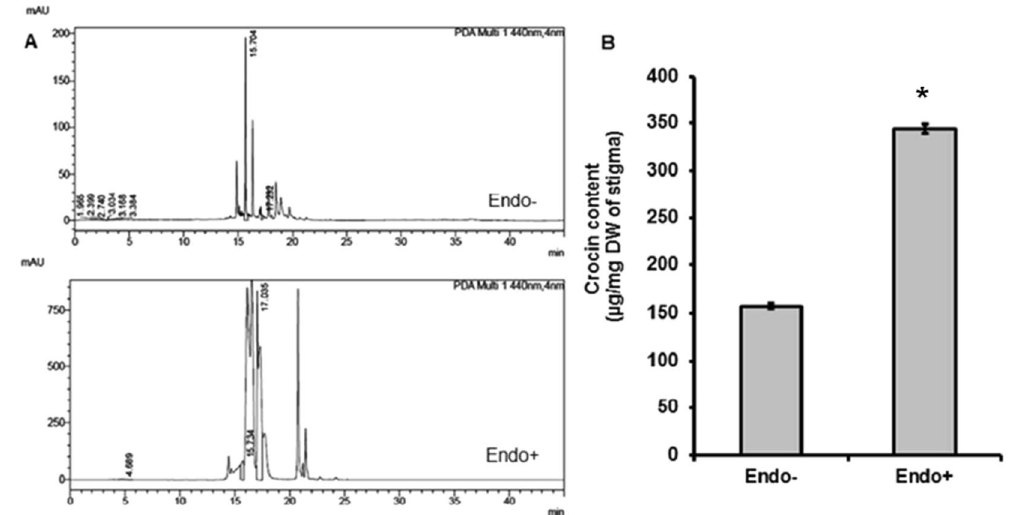
Figure 2. Effect of the CS10E4 on crocin content of saffron. ( A ) HPLC chromatograms showing crocin peaks in endophyte free (Endo − ) and endophyte treated (Endo + ) Crocus stigma samples ( B ) Bar diagram showing crocin content ( µ g/mg dry weight of stigma) in endophyte treated and control plants. Values are the means ± S.D. Comparisons among means were carried out using Student T test at a significance level of P ≤ 0.05 using GraphPad InStat tm software